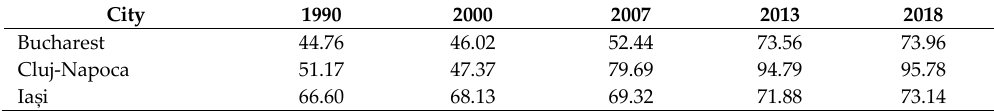
Table 2: Percentage of modernised* roads within each city City 1990 2000 2007 2013 2018 44.76 *Modernised town streets (km) = streets with shaped -stone, asphalt, or concrete covering. The parts paved with shaped stone include coverings of cubic, parallelepiped stone or stone of other regular shapes